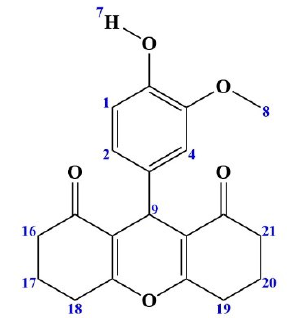
Fig. 4. Compound 1 proton